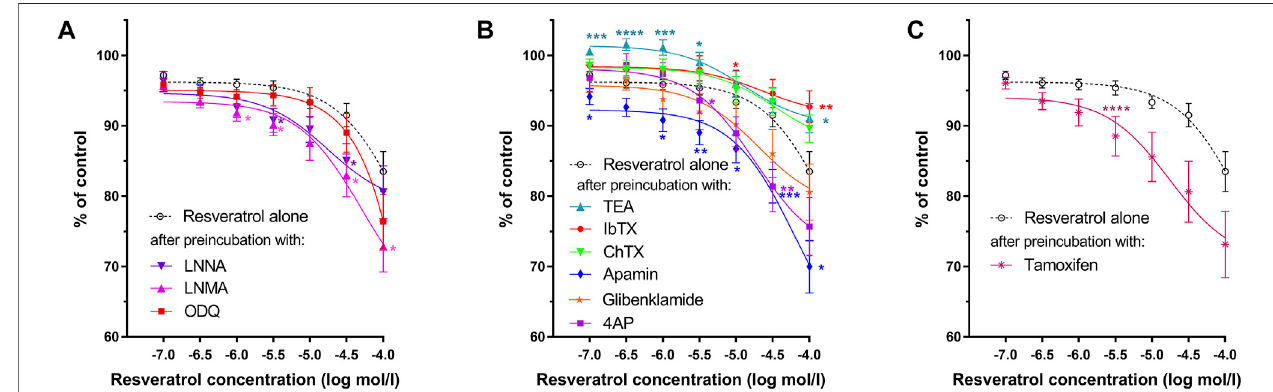
FIGURE3| EffectsofresveratrolonthegastricmusclesamplesasmeasuredbyAUCafterpreincubationwith (A) — L-NNA,L-NAME,ODQ; (B) — TEA,IbTX,ChTX, apamin glibenclamide or 4AP; (C) — tamoxifen. Each point represents the mean ± SEM of AUC values obtained from individual strips ( n (cid:1) 10) from different patients. AUCofcarbachol-inducedcontractionsofeach gastricstripovera10-minintervalbeforetheadditionoftheantagonistwastreatedascontrol.Signi fi canceat* p < 0.05; ** p < 0.01; *** p < 0.001; **** p < 0.0001 as compared to the AUC of resveratrol alone.